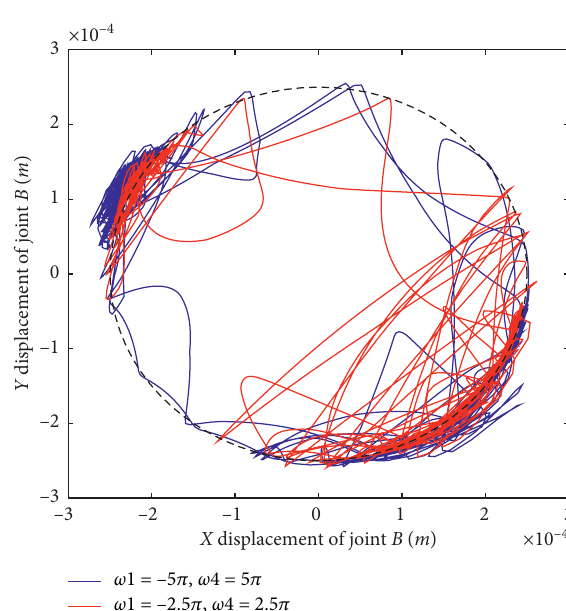
Figure 23: Shaft center trajectory at pair B .